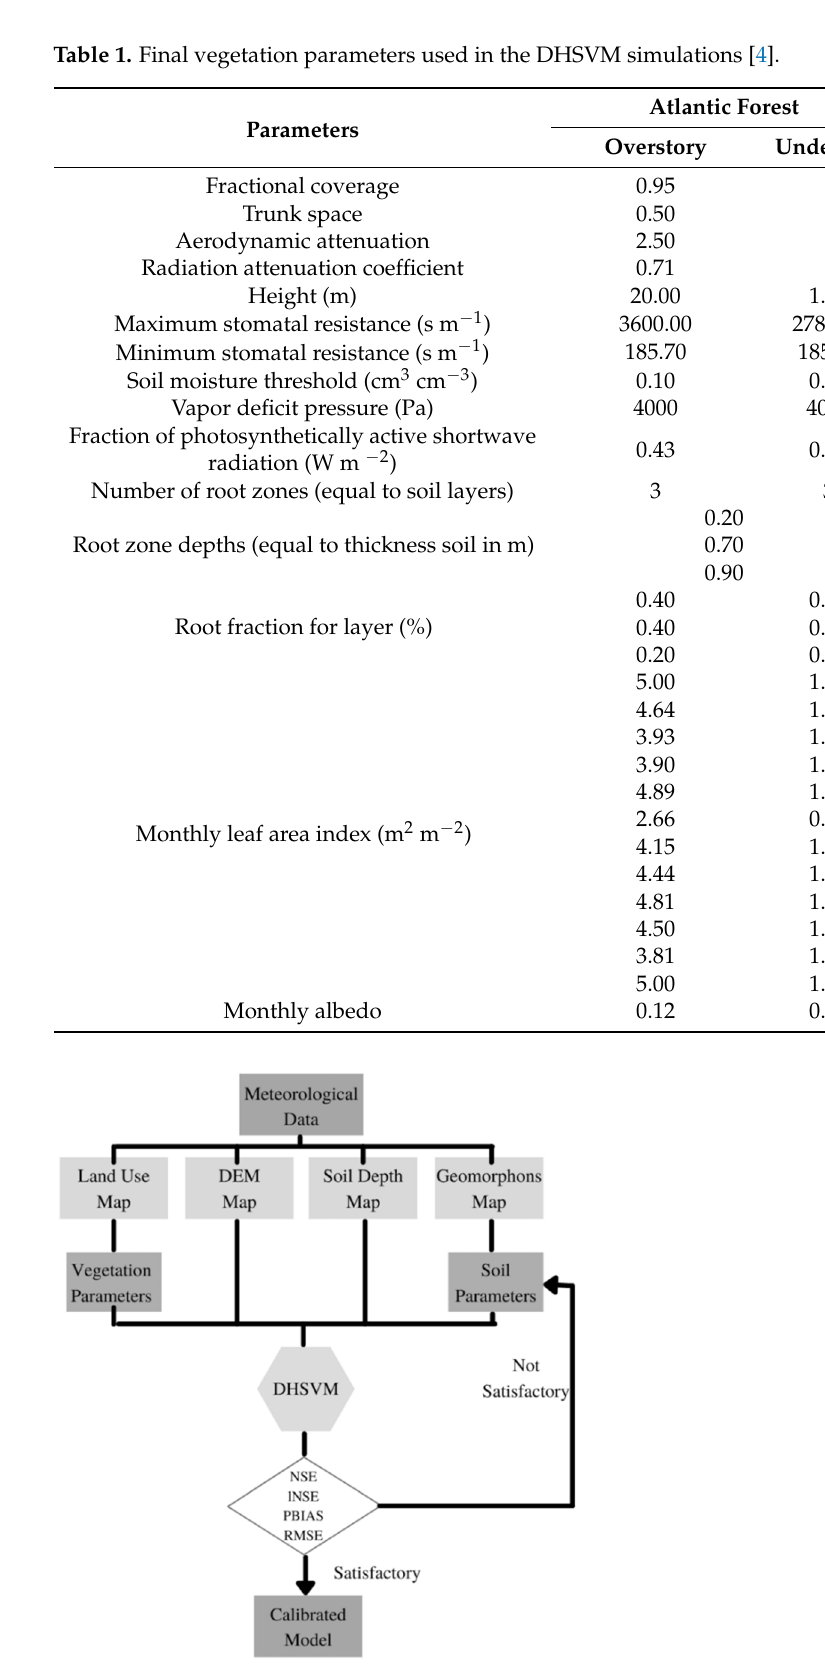
Figure 3. Flowchart of the modelling calibration framework.